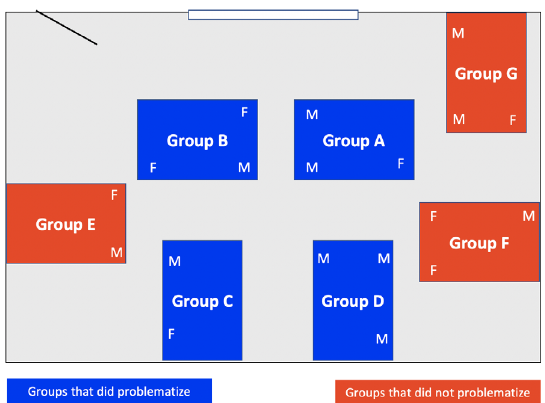
FIG. 3. Diagram of the classroom layout. Numbers and approximate seating arrangement of female (F) and male (M) students are shown. Groups in blue (A, B, C, and D) did problematize around the intended problem. Groups in red (E, F, and G) did